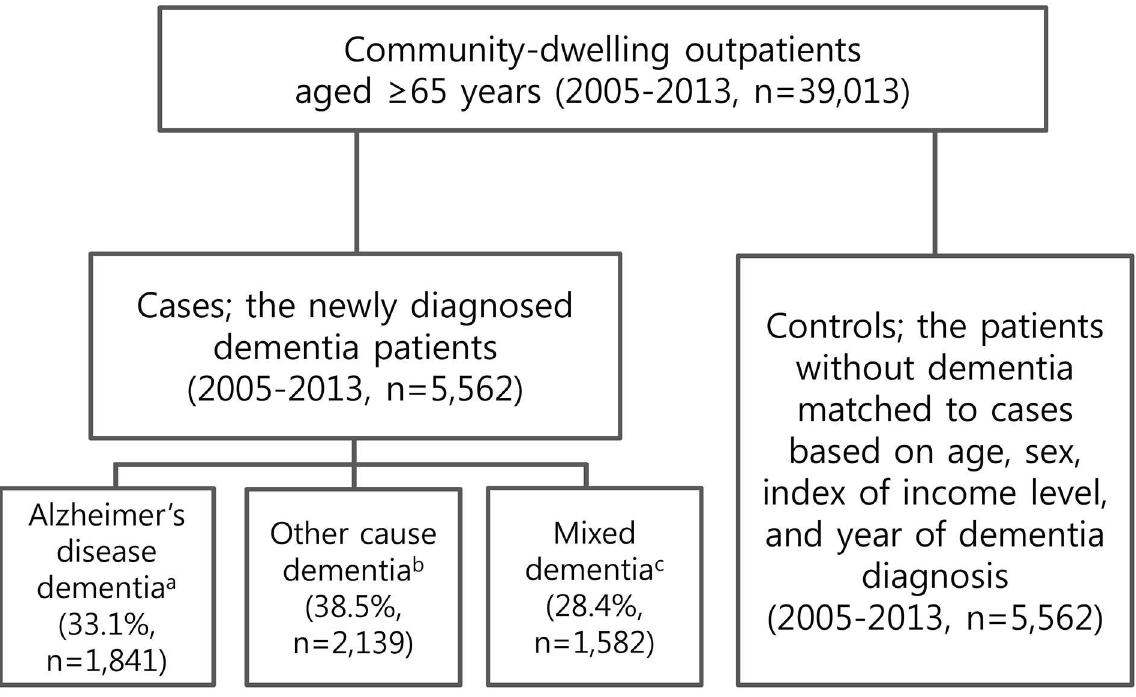
Fig 1. Selection of cases and controls. a Alzheimer’s diseasedementia: patients with ICD-10 codes of F00 and G30, without F01, F02, F03, F051, and G311. b Other cause dementia: patients with ICD-10 codes of F01, F02, F03, F051, and G311, without ICD-10 codes of F00 or G30 c Mixed dementia: patients with Alzheimer’s diseasecodes (F00 or G30) and any other cause dementiacodes (F01, F02,F03, F051, G311)